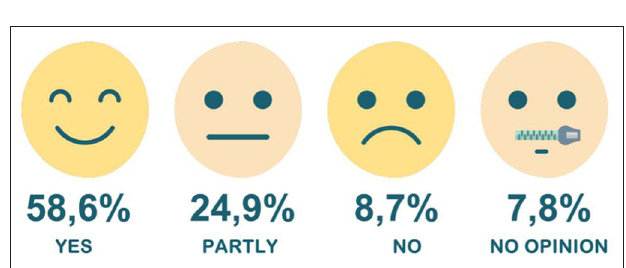
FIGURE 9 | AVASUS contribution to meeting health services